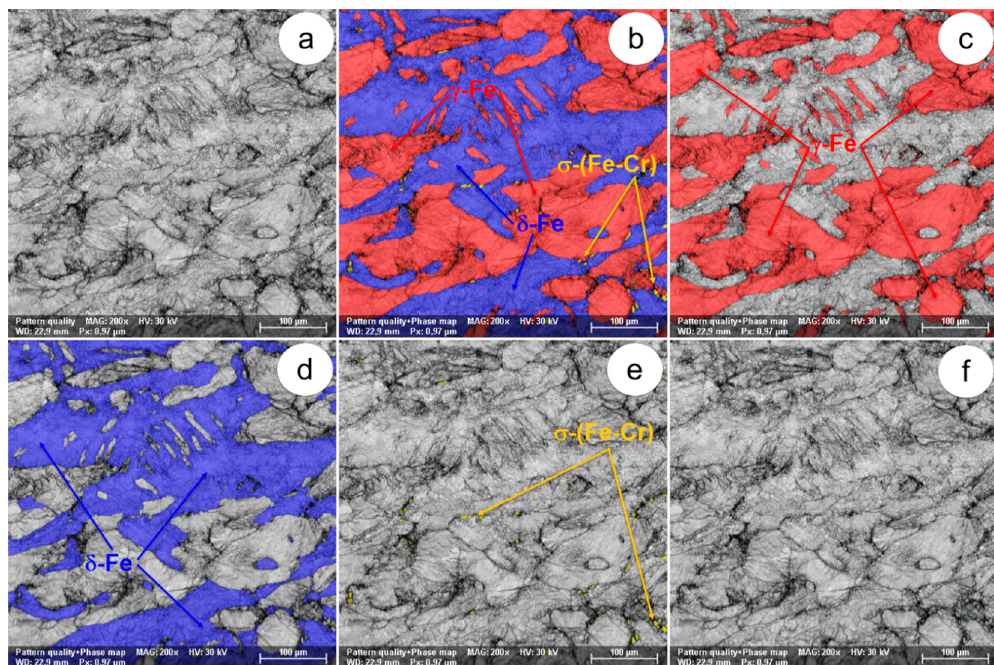
Figure 12. The SEM-EBSD composite images (×200) obtained after forging at 1000 °C: ( a ) the microstructure of the analysed field; ( b ) the distribution of existing phases in the microstructure of the analysed field; ( c ) the distribution of the γ -Fe phase; ( d ) the distribution of the δ -Fe phase; ( e ) the distribution of the σ -(Fe-Cr) phase; ( f ) the distribution of the χ -(Fe-Cr-Mo) phase.